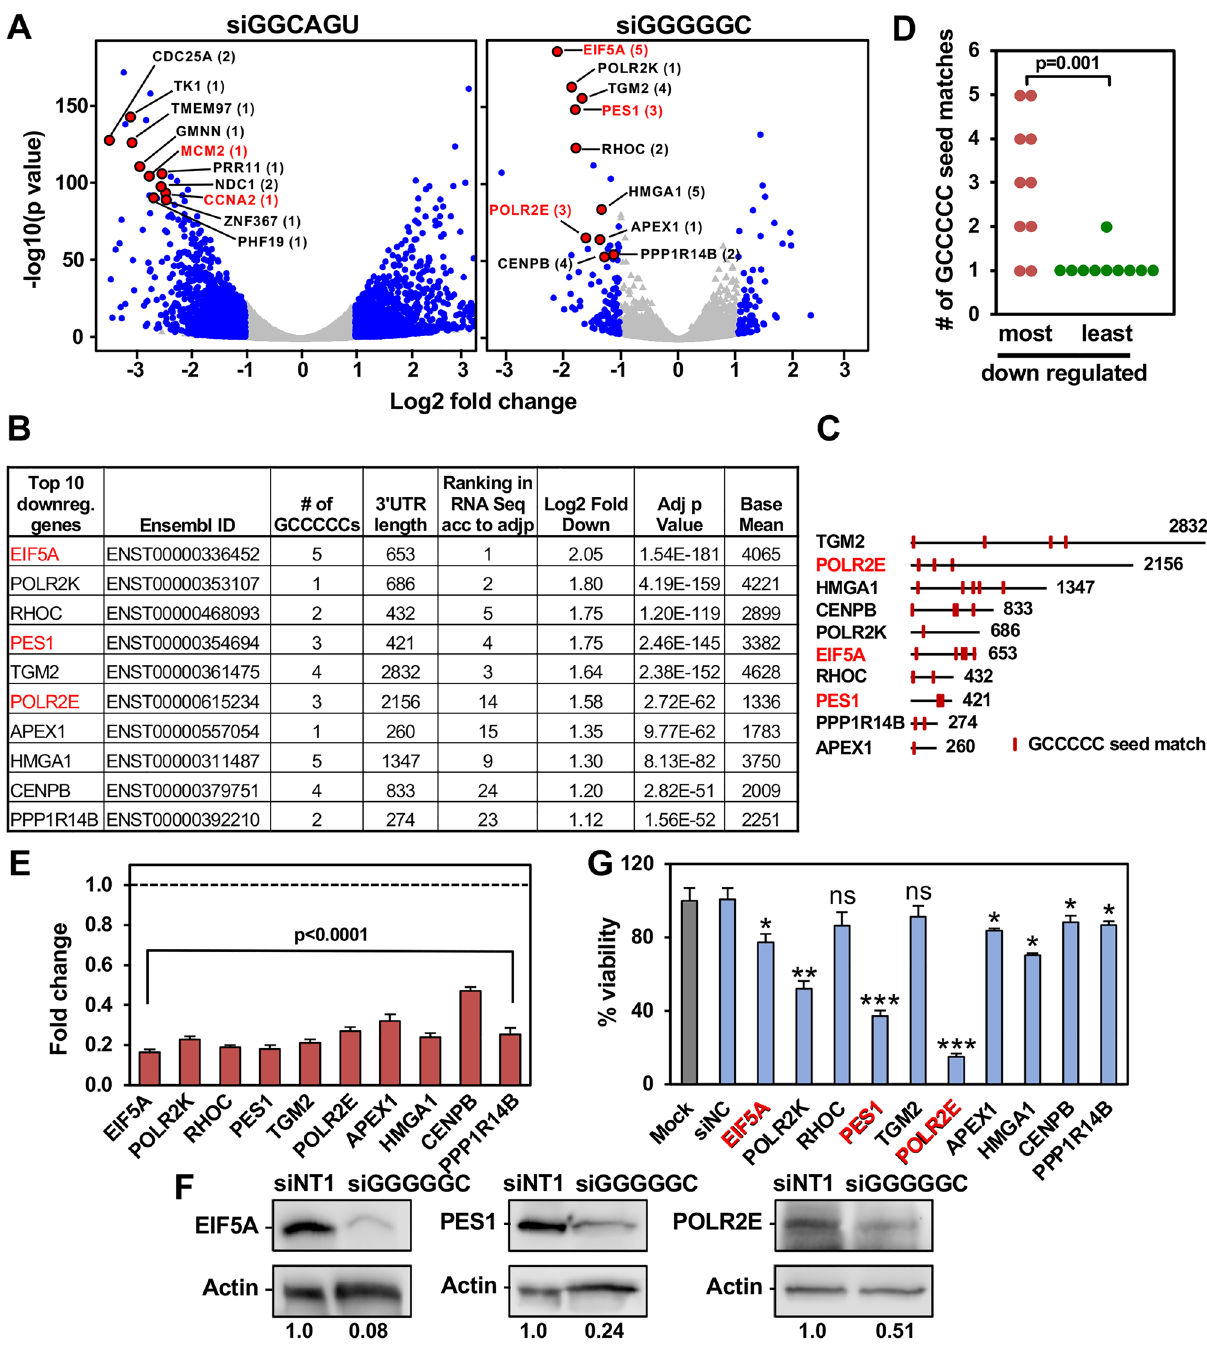
Figure 4. siGGG GGC kills cells by targeting GCC CCC seed matches located predominantly in the 3 ′ UTR of targeted mRNAs. ( A ) Volcano plot of deregulated genes in HeyA8 cells transfected with 10 nM siGGG GGC vs. siNT1 (after 24 h) or with 10 nM siGGC AGU vs. siNT1 (after 48 h). Red dots indicate genes that were most highly expressed (>1000 norm reads) and down regulated. The number of GCC CCC seed matches is given in brackets. Grey dots indicate all differentially expressed genes (with a log2 fold change < 3 and > − 3), blue dots indicate genes with log2 fold change > 1 and FDRAdjpValue < 0.05. ( B ) Table showing the 10 downregulated genes labeled in A ranked (from top to bottom) according to Log2 fold change. ( C ) Schematic of the 3 ′ UTRs of the 10 genes listed in B with the location of the GCC CCC seed matches. ( D ) The number of predicted seed matches in the ten most and least downregulated and highly expressed genes part of the 5957 genes in the human genome that contain at least one such seed match in their 3 ′ UTR. p-value was calculated by Student’s t test. ( E ) Real-time PCR validation of downregulation of the ten genes in ( B ) derived from RNA seq analysis (24 h time point). Gene expression levels in HeyA8 cells transfected with siGGG GGC were normalized to GAPDH and to cells transfected with siNT1 (stippled line). Each bar represents ± SD of three replicates. Student’s t test was used to calculate p-values for each gene. ( F ) Western blot analysis for EIF5A, POLR2E, PES1 and actin in HeyA8 cells transfected with 20 nM siNT1 or siGGG GGC for 48 h. Quantification of bands normalized to actin is shown. ( G ) Viability of HeyA8 cells 96 h after transfection with 10 nM of siRNA SmartPools against the ten genes in B. Each bar represents ± SD of three replicates. Student’s t test, ***p < 0.0001, **p < 0.001, *p < 0.05, ns, not significant. Genes that are part of our curated list of survival genes are labeled in